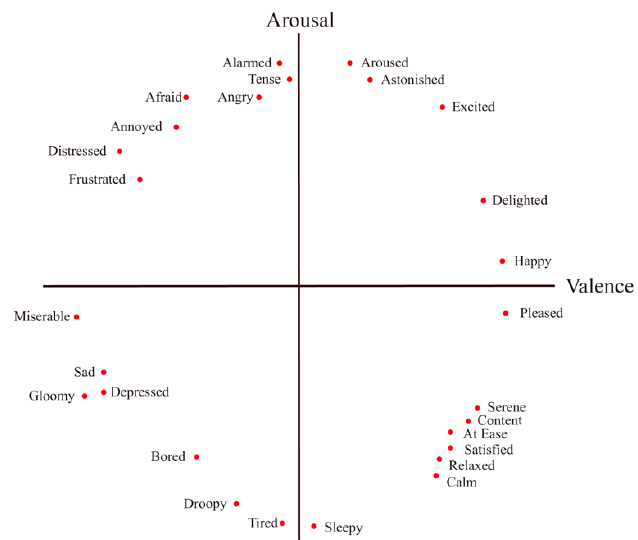
Figure 1 . Russell’s circumplex model. The circumplex model is developed by James Russell. In the model, emotions are distributed in a two-dimensional plane. The x-axis represents valence and the y-axis represents arousal. Valence refers to the positive and negative degree of emotion and arousal refers to the intensity of emotion. Using the circumplex model, emotional states can be presented at any level of valence and arousal.